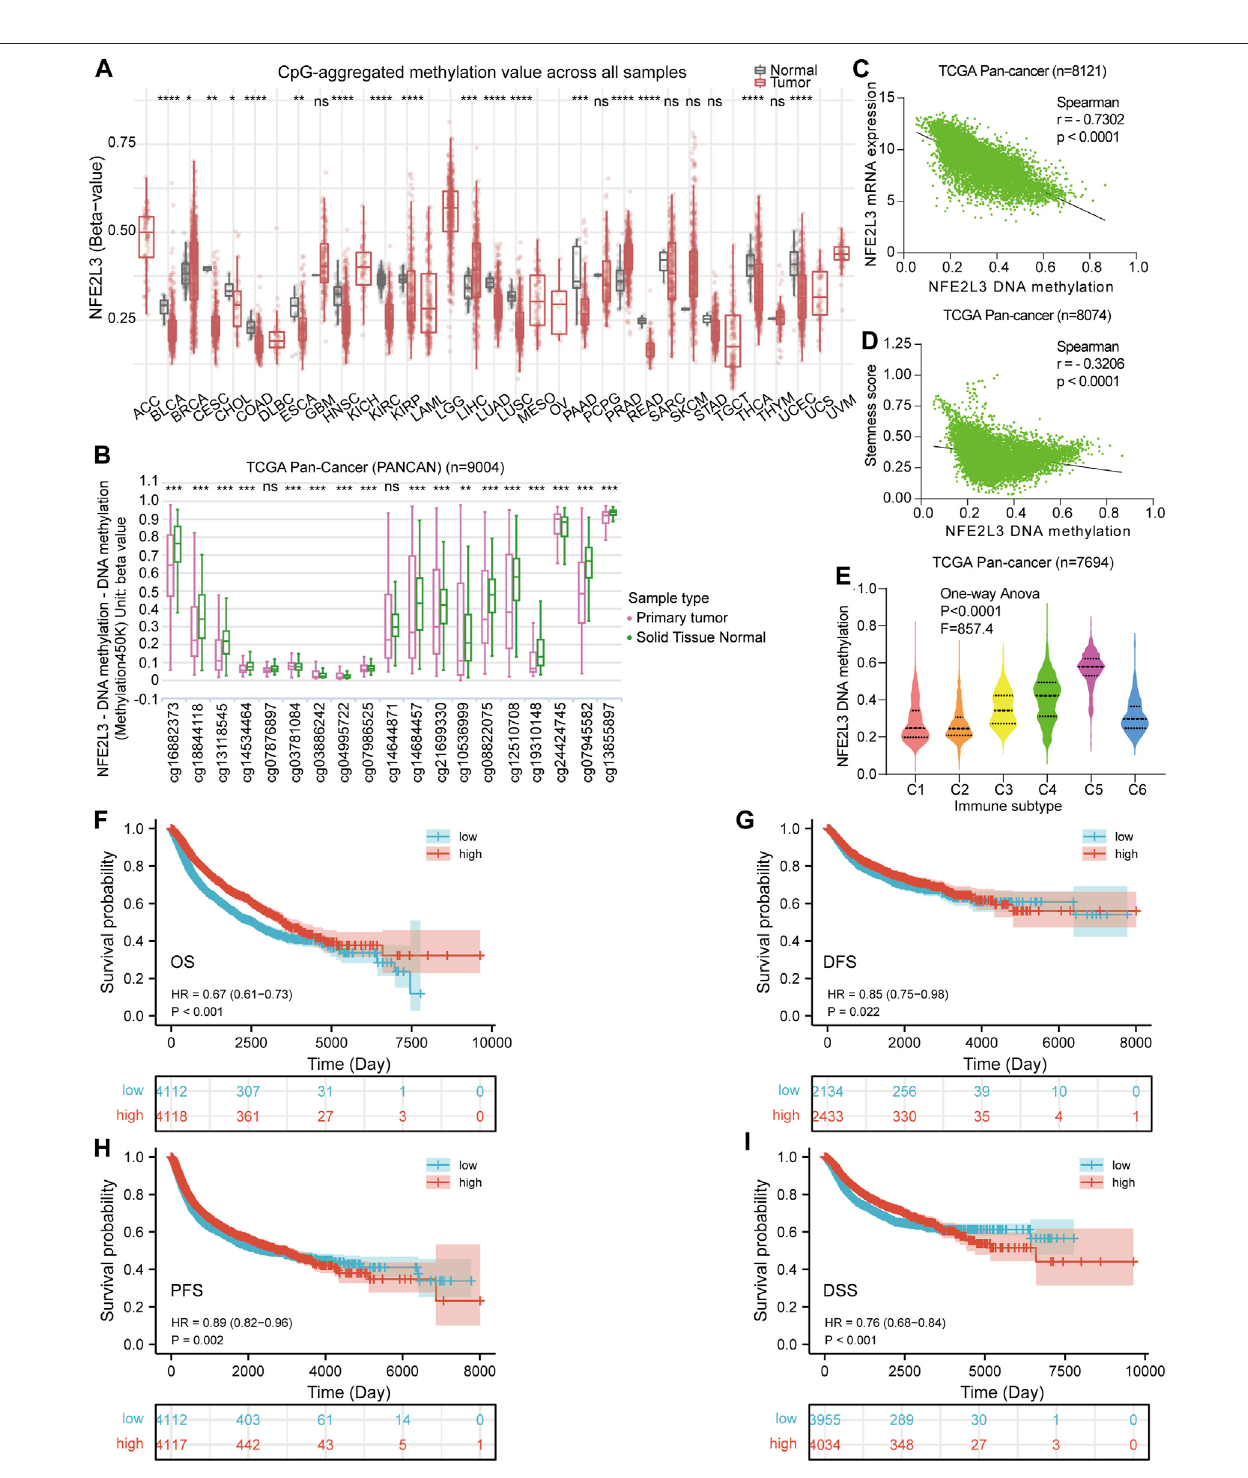
FIGURE 5 | DNA methylation analysis of NFE2L3 in pan-cancer. (A) Analysis of DNA methylation levels of NFE2L3 in pan-cancer using the SMART database. (B) The 19 CPG methylation sites of NFE2L3 in TCGA pan-cancer (PANCAN) cohort were analyzed by the UCSC Xena database for comparison of NFE2L3 DNA methylation levels between tumor and normal groups. (C) The correlation between DNA methylation levels of NFE2L3 and NFE2L3 mRNA expression levels in TCGA PANCAN cohort. (D) The correlation between DNA methylation levels of NFE2L3 and tumor cell stemness in TCGA PANCAN cohort. (E) The DNA methylation levelsofNFE2L3indifferentimmunesubtypesinTCGAPANCANcohort. (F – I) TheassociationbetweenDNAmethylationlevelsofNFE2L3andOS,disease-freesurvival (DFS), PFS, and disease-speci fi c (DSS) prognosis in TCGA PANCAN cohort. ns, p ≥ 0.05; p , p < 0.05; pp , p < 0.01; ppp , p < 0.001; ****, p < 0.0001.